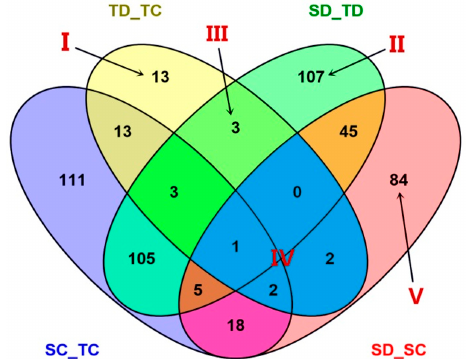
Figure 3. Venn diagram analysis of differentially abundant proteins (DAPs) identified in the four experimental comparisons. The overlapping regions of the Venns indicate the DAPs shared between/among corresponding groups. Area I represents 13 drought responsive DAPs specific to TD_TC; Area II represents 107 DAPs exclusive to SD_TD; Area III shows the 3 DAPs specifically shared between TD_TC and SD_TD; Area IV shows the five overlapping DAPs within line (shared between TD_TC and SD_SC); Area V shows 84 DAPs exclusive to SD_SC comparison.